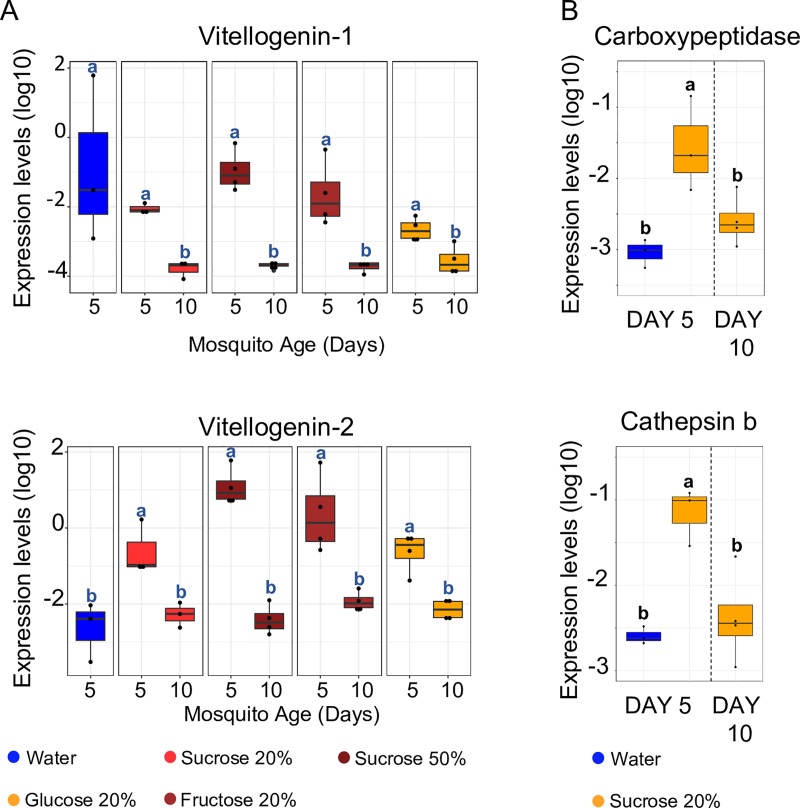
Confirmation of the ‘vitellogenic wave’ in the fat body via RT-qPCR in an independent experiment including different sugar diets.(A) While Vg-2 consistently showed the expected expression pattern, Vg-1 was also up-regulated in water-fed females in this experiment, making Vg-2 the more likely candidate gene regulating host-seeking behaviour. (B) Vitellogenic carboxypeptidase and cathepsin B consistently display the same ‘vitellogenic wave’ expression pattern as Vg-2. Results are expressed as log10 deltaCT ± SE, using the Ribosomal Protein S17 as a reference gene. Letters indicate significant differences based on the Kruskal–Wallis rank-sum test followed by Dunn’s post hoc test with Benjamini–Hochberg correction (Vg-1) and one-way ANOVA, followed by Tukey’s post hoc test (Vg-2, vitellogenic carboxypeptidase, cathepsin B). N = 3–4 pools, each containing the fat bodies from 4–7 females. The underlying data can be found within S2 Data. RT-qPCR, Reverse Transcriptase quantitative polymerase chain reaction; Vg, vitellogenin.